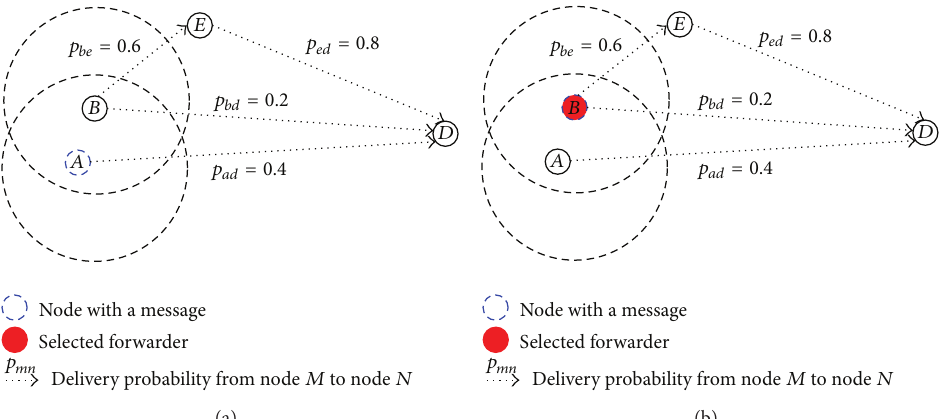
Figure 1: Comparison of different routing algorithms for message forwarding in a DTN where 𝑝 𝑎𝑑 > 𝑝 𝑏𝑑 and 𝑝 𝑏𝑒𝑑 > 𝑝 𝑎𝑑 . (a) PRoPHET in [16, 17], where node 𝐴 continues to carry the message. (b) Probabilistic routing based on two-hop neighbors’ information, where node 𝐵 is selected as the forwarder to carry the